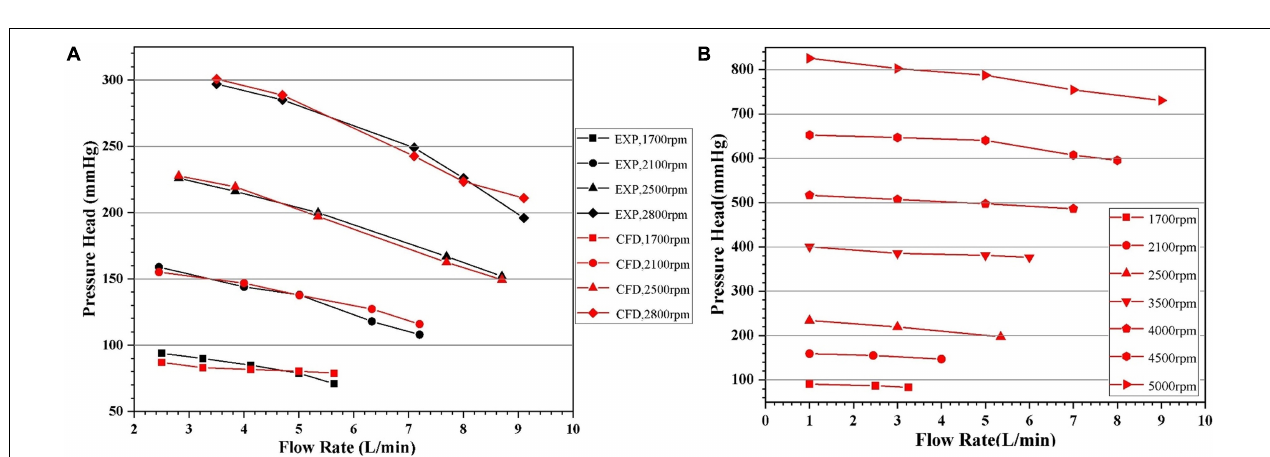
FIGURE 8 | Head-flowrate (H-Q) curves predicted by CFD: (A) in comparison with experiment for certain rotational speeds, with the black and red symbols representing experimental and CFD data, respectively; (B) with pressure head up to 800 mmhg.